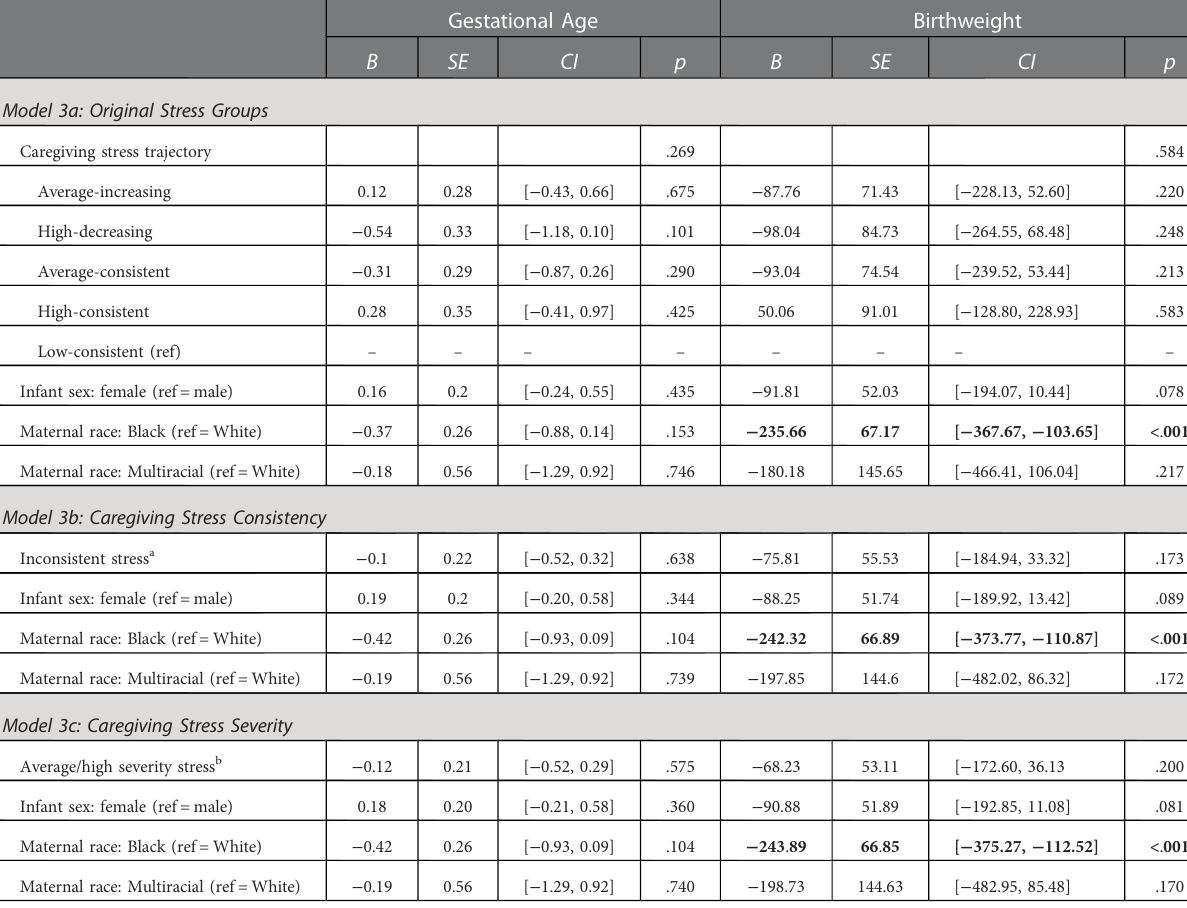
TABLE 6 Preconception exposure to caregiving stress predicting offspring birth